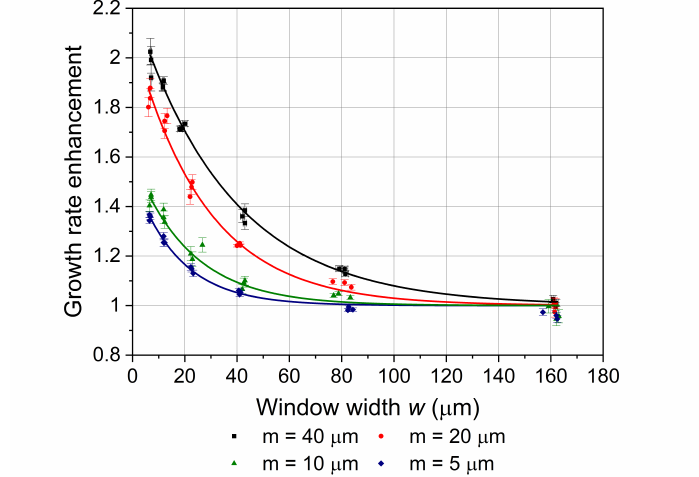
Figure 8. GRE as a function of the window width in the window center GRE center = f ( w ) (layer thickness 500